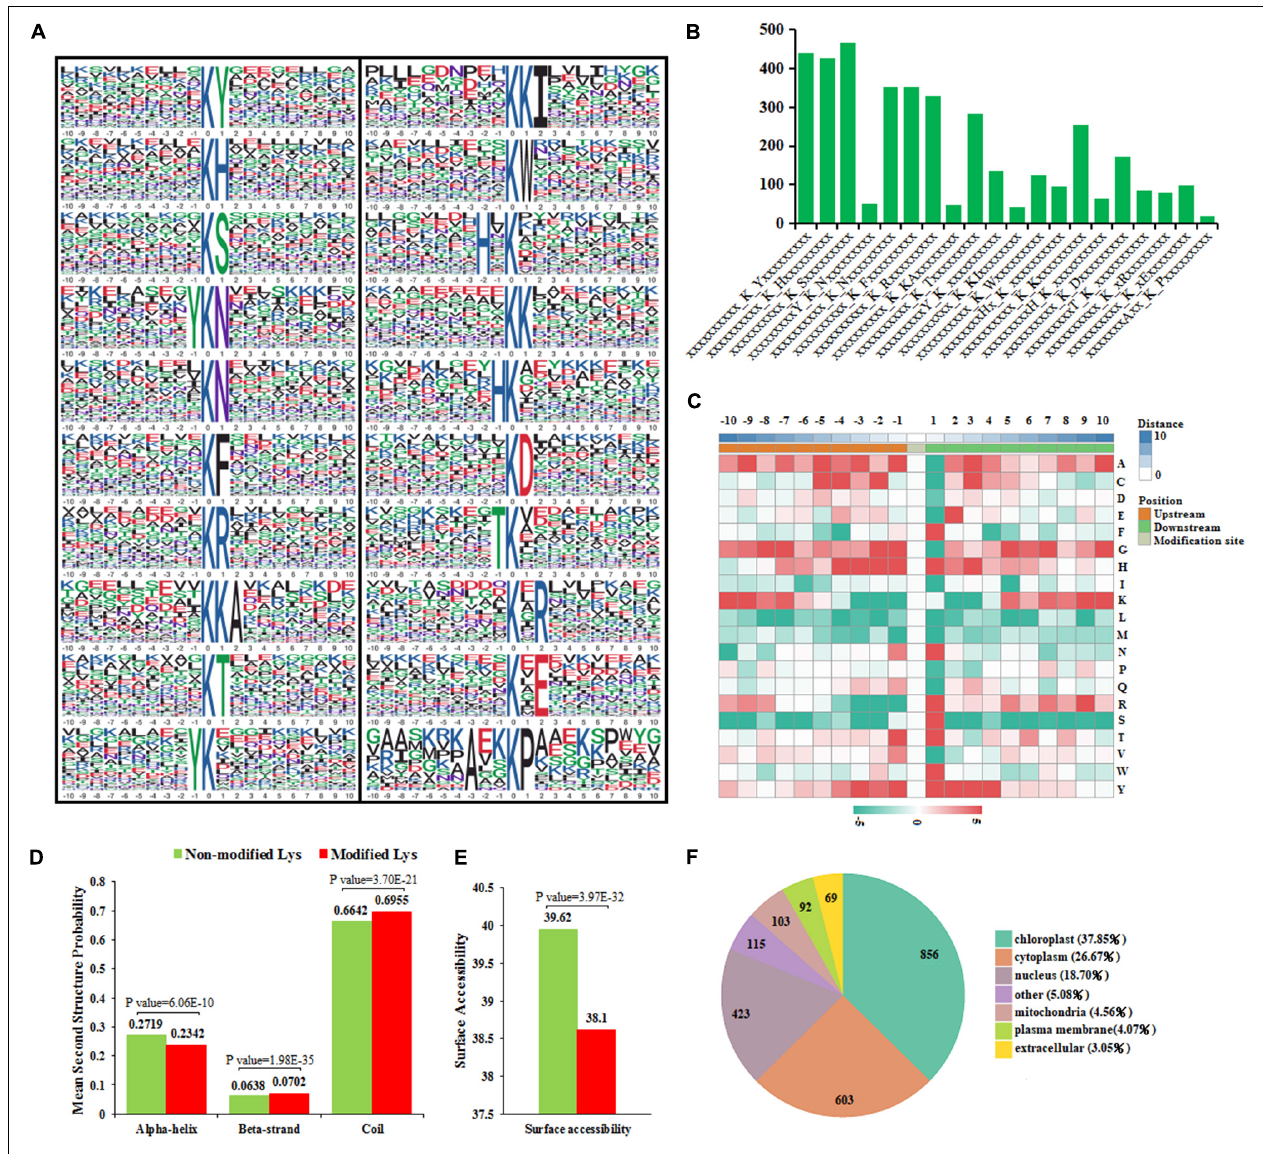
FIGURE 6 | Functional bioinformational analysis of acetylated proteins. (A) Sequence motif analysis of acetylated sites. (B) The number of identified peptides containing acetylated sites in each motif. (C) The relative abundance of amino acid residues flanking the acetylated sites represented by an intensity map. (D) Comparison of non-modified and modified-acetylated proteins amino acids in protein secondary structures. (E) Comparison of non-modified and modified-acetylated proteins amino acids in protein surface accessibility. (F) Distribution of the acetylated proteins in subcellular